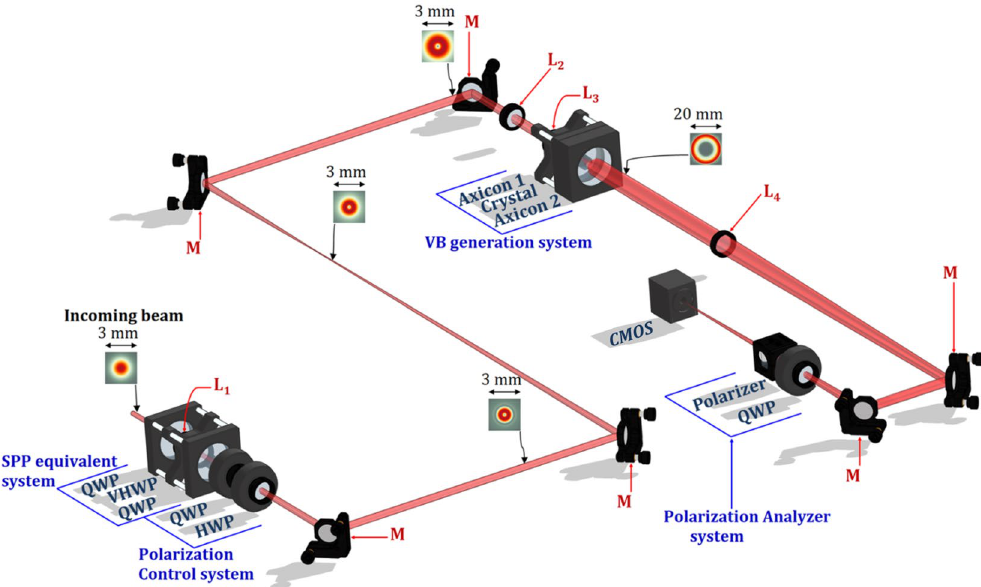
Figure 2. The experimental setup comprises four main parts: an SPP equivalent system consisting of two quarter-wave plates—QWP and a vortex half-wave plat—VHWP; a Polarization Control system composed of a quarter-wave plate—QWP and a half-wave plate—HWP; a Vector Vortex Beam generation system which contains two fused silica ultra-quality axicon lenses with physical angle of 20°—Axicon 1 and Axicon 2 and a uniaxial Crystal, and a Polarization Analyzer system made up of a quarter-wave plate—QWP and a Polarizer. The mirrors M were used to direct the laser beam throughout the optical system up to the CMOS-video camera. L 1 , L 2 , L 3 , L 4 : lenses used in laser beam collimation and focusing processes. The focal lengths of the lenses are